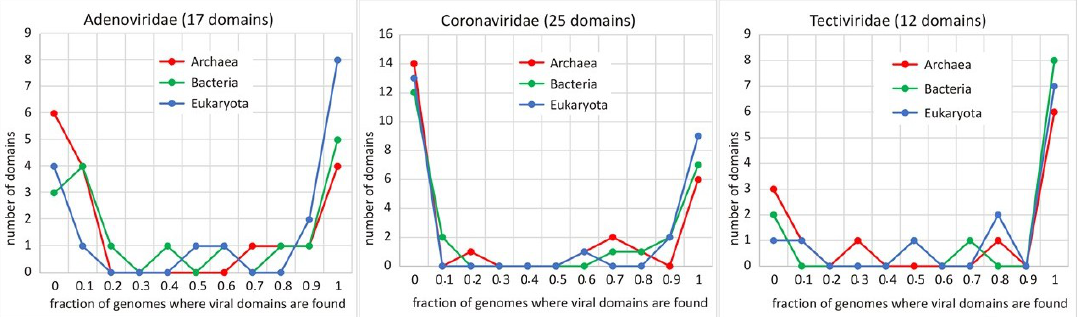
Figure 6. Distribution of the protein domains found in three viral families according to their occurrence in different superkingdoms. Protein domains as they are defined in SCOPat the superfamily level and the occurrence of these domains according to Superfamily assignment (www.supfam.org). For example, Coronaviridae encodes 13 protein domains not found in eukaryotic genomes and nine domains found in more than 90% of eukaryotic